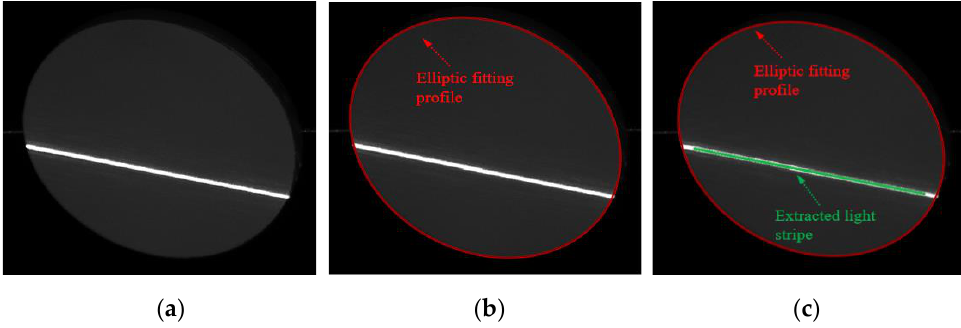
Figure 2. Calibration images. ( a ) Captured image of the circle target. ( b ) Elliptic fitting profile. ( c ) Extracted light stripe.